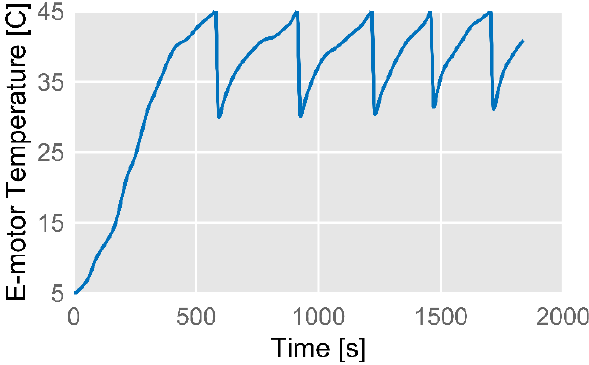
Figure 20. Motor temperature variation throughout time for a one-way journey of the